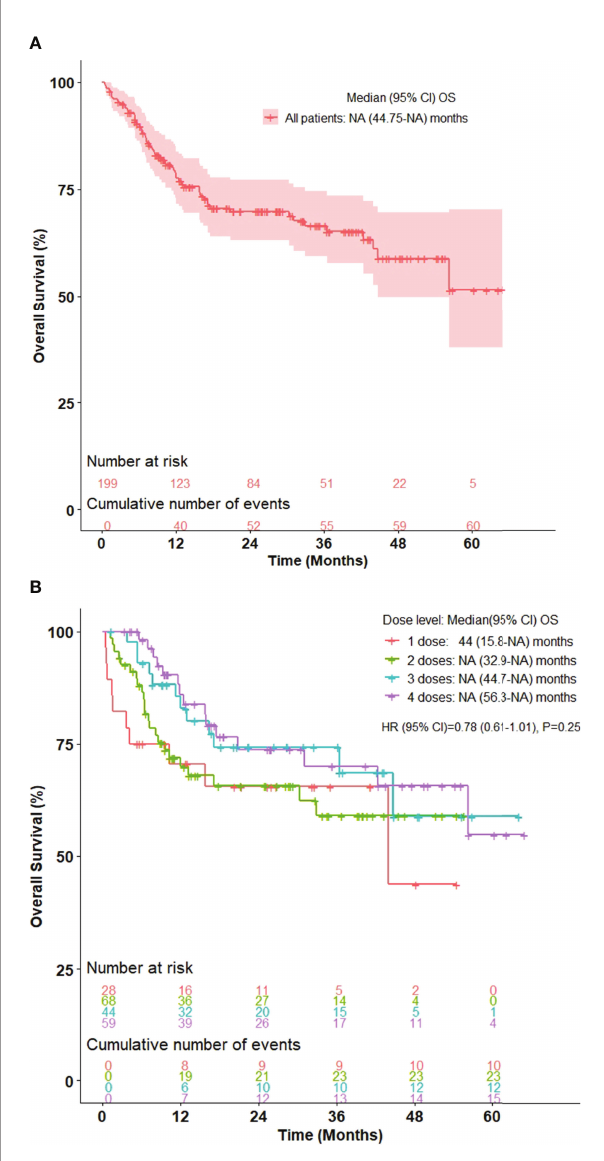
FIGURE 1 | Kaplan-Meier curve for progression-free survival in advanced stage melanoma patients treated with ipilimumab/nivolumab in (A) all patients and (B) strati fi ed by number of ipilimumab/nivolumab doses received. n = 199.